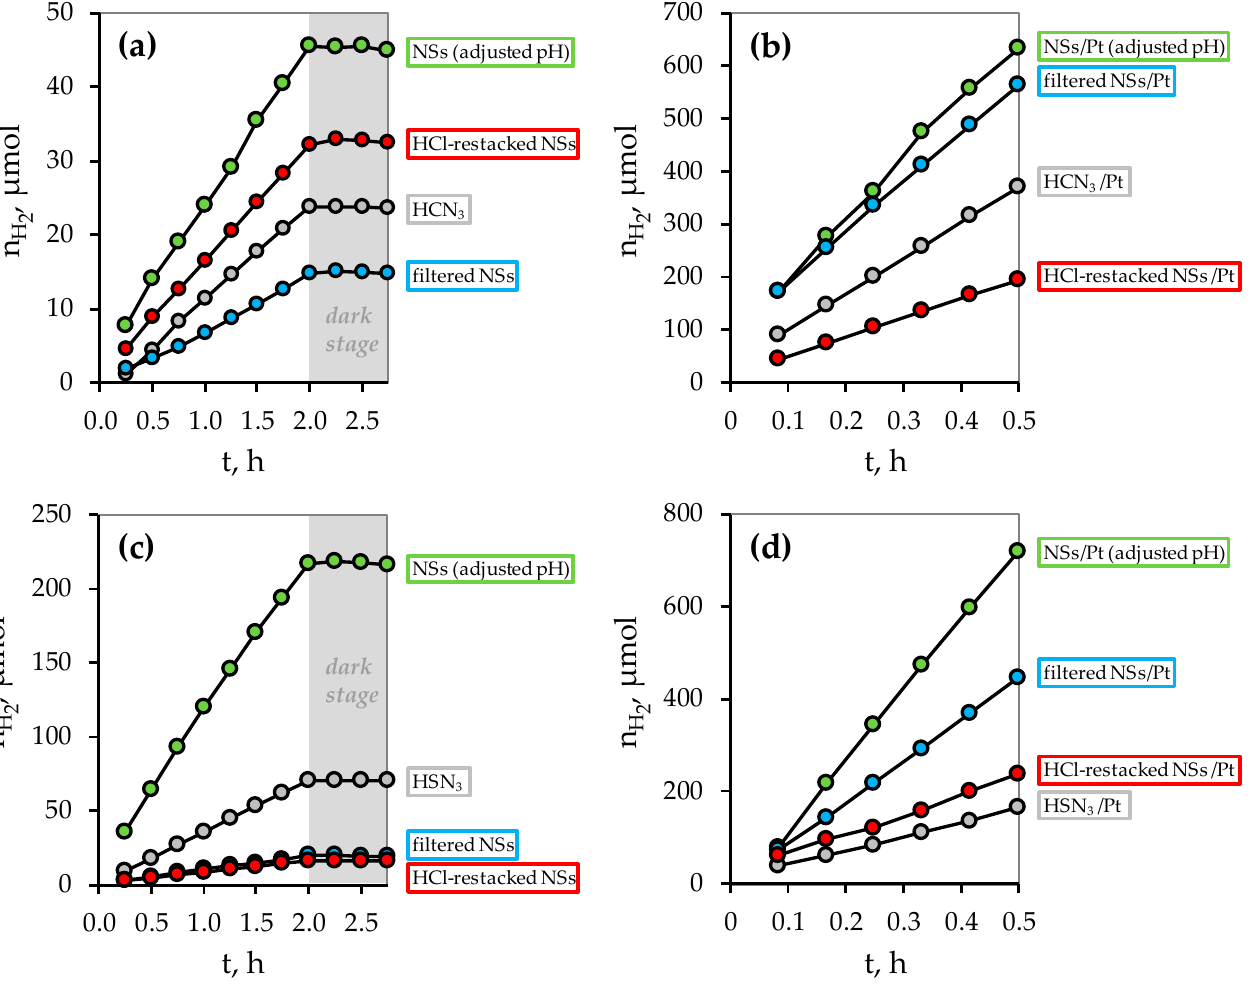
Figure 7. Kinetic curves of photocatalytic hydrogen evolution from 1 mol.% aqueous methanol over the HCN 3 ( a , b ) and HSN 3 ( c , d ) protonated niobates and their nanosheet-based photocatalysts.